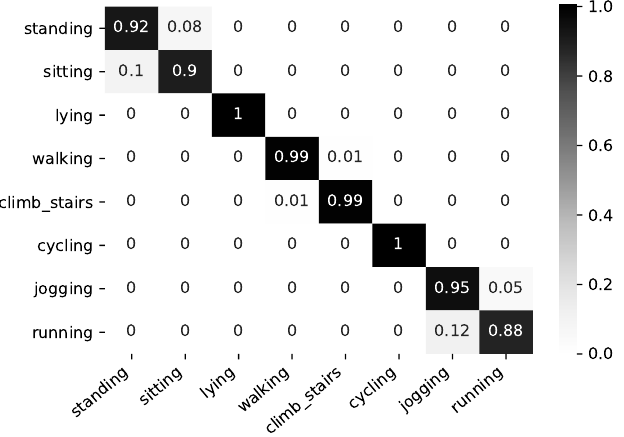
Figure 11. Confusion matrix for the two-layer multimodal fusion approach.